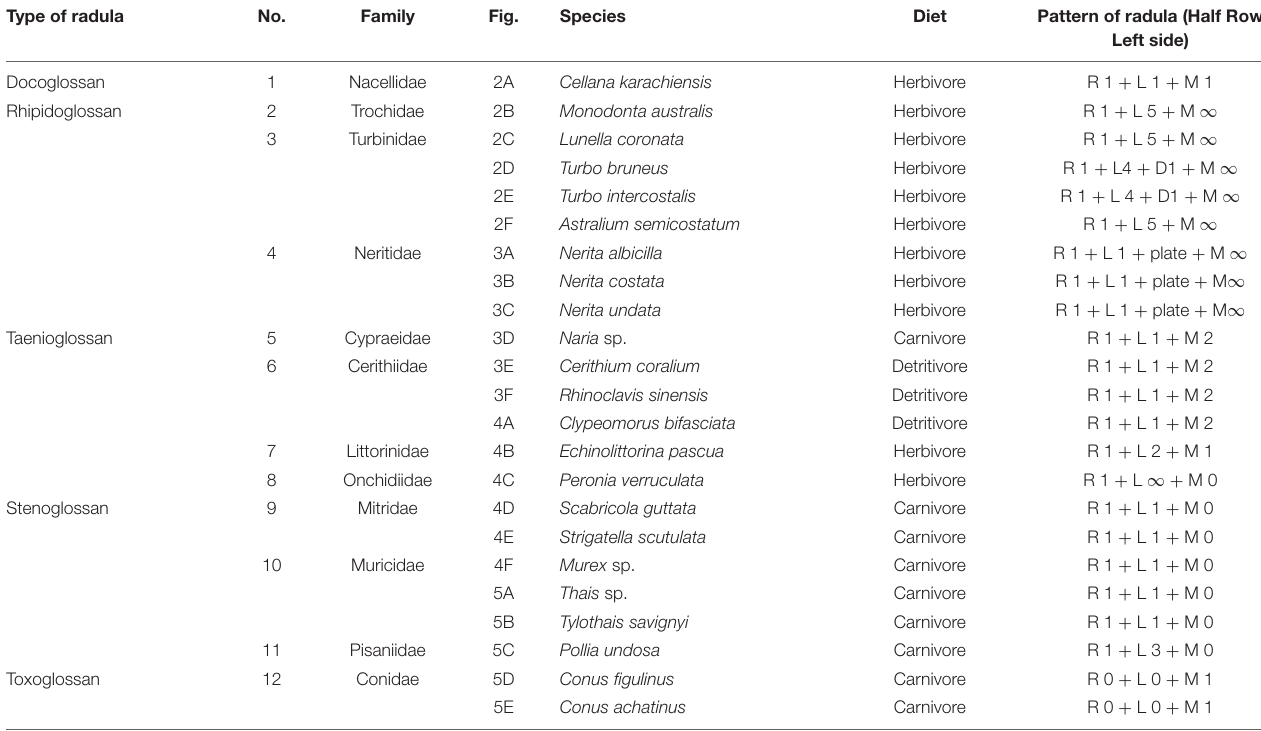
TABLE 1 | Radular pattern of selected species. Family Fig. Species Diet Pattern of radula (Half Row